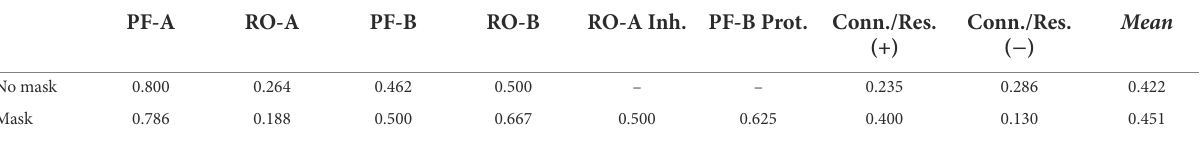
TABLE 5 Level 3: Body reference index across categories and conditions.